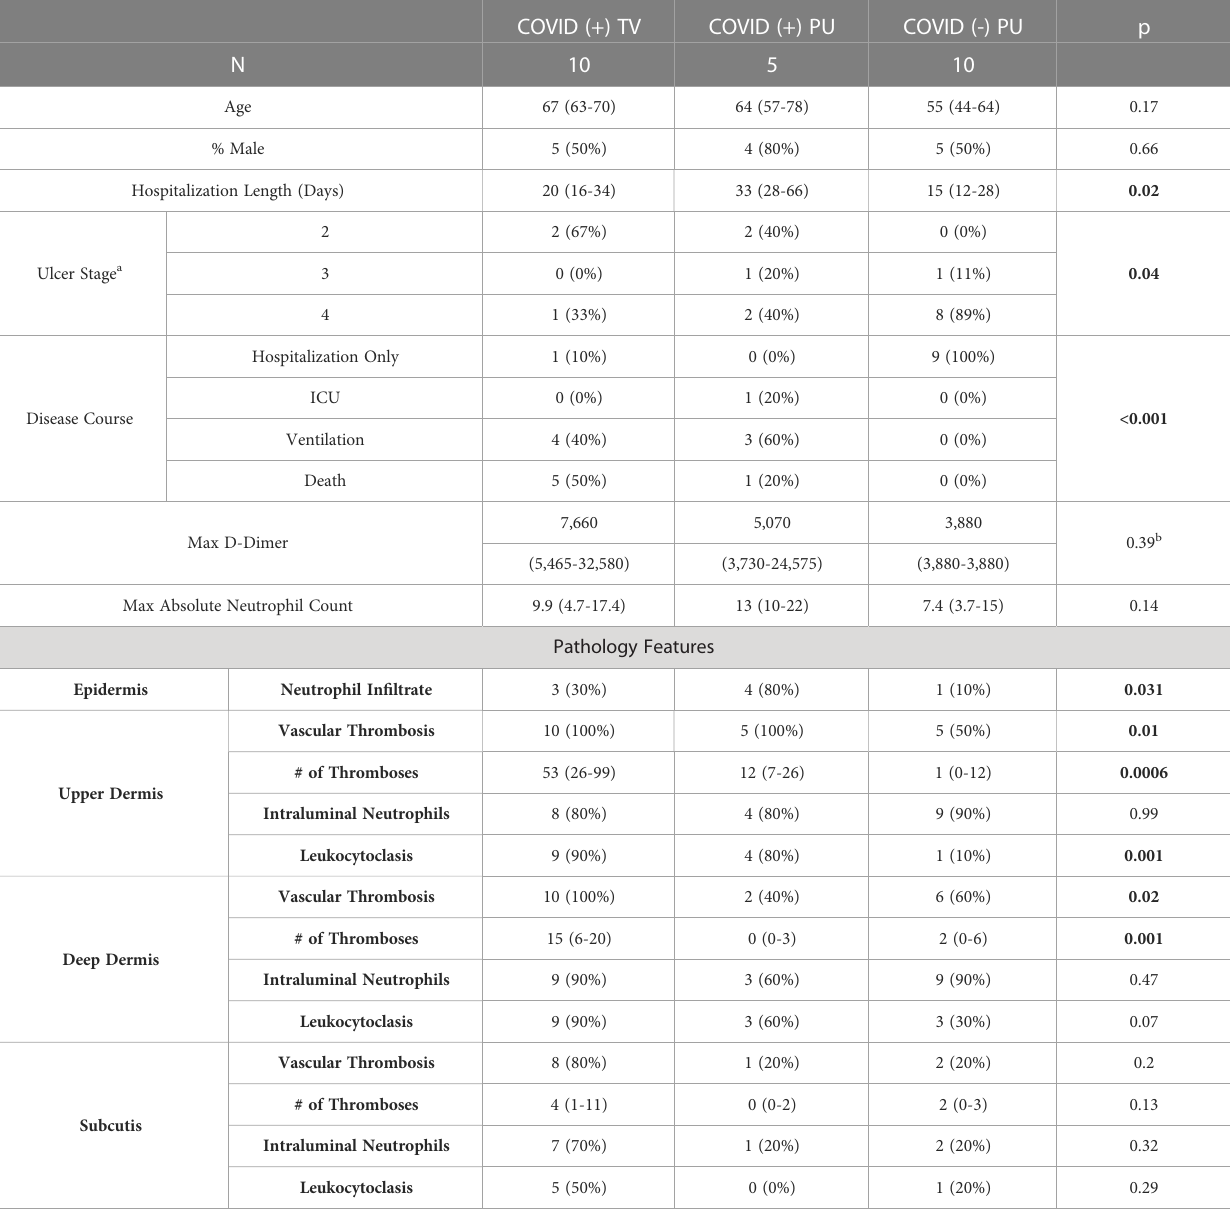
TABLE 3 Clinical and pathological characteristics of biopsied